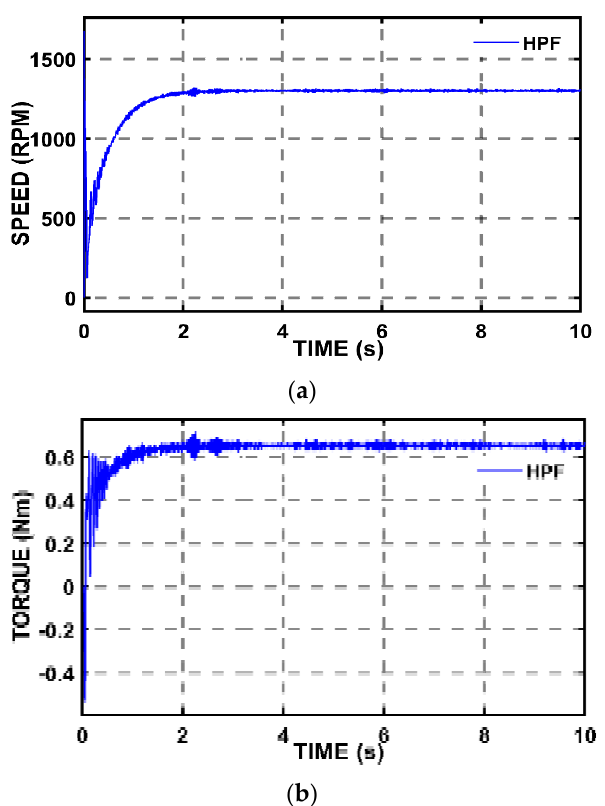
Figure 11. Speed and torque performance for case 2. ( a ) Speed. ( b ) Torque.